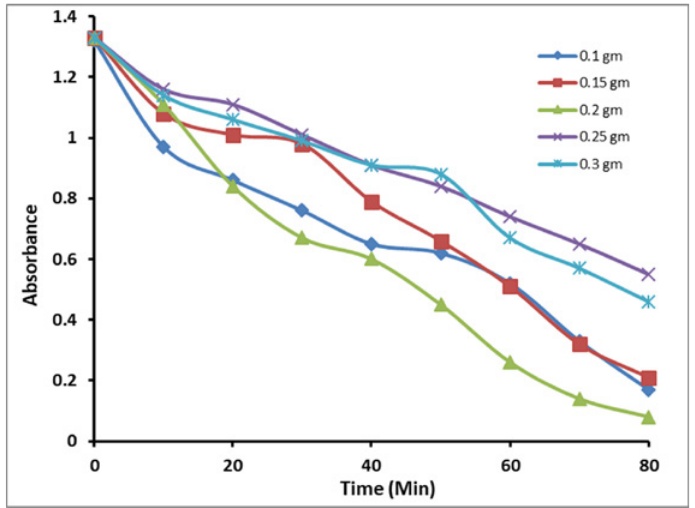
Fig. 7. Effect of amount of photocatalyst on nigrosine dye